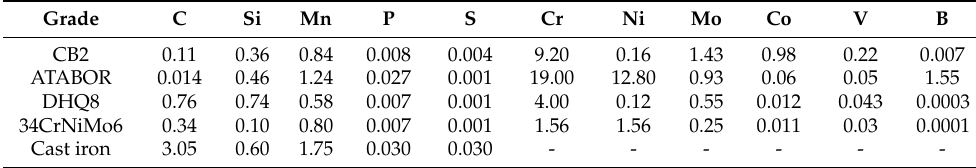
Table 1. A list of materials used for the simulation. Chemical composition in wt.%.